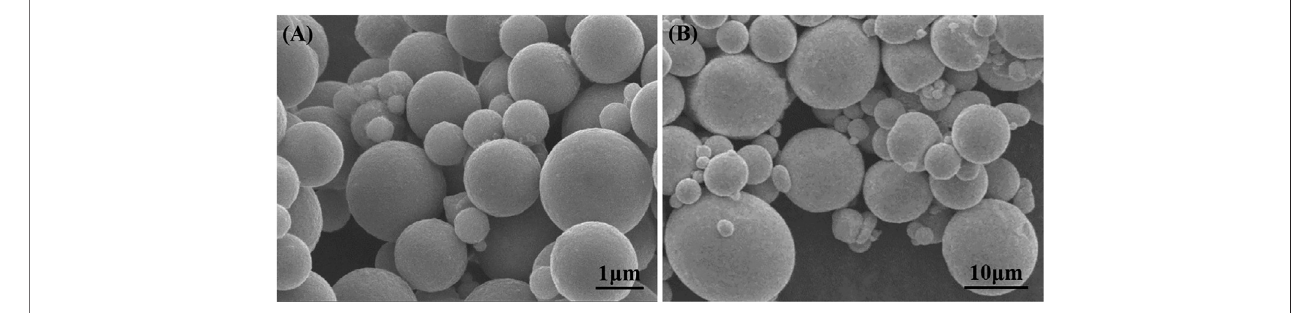
FIGURE 1 | Microscopic morphology of powders: (A) Cu and (B) In.